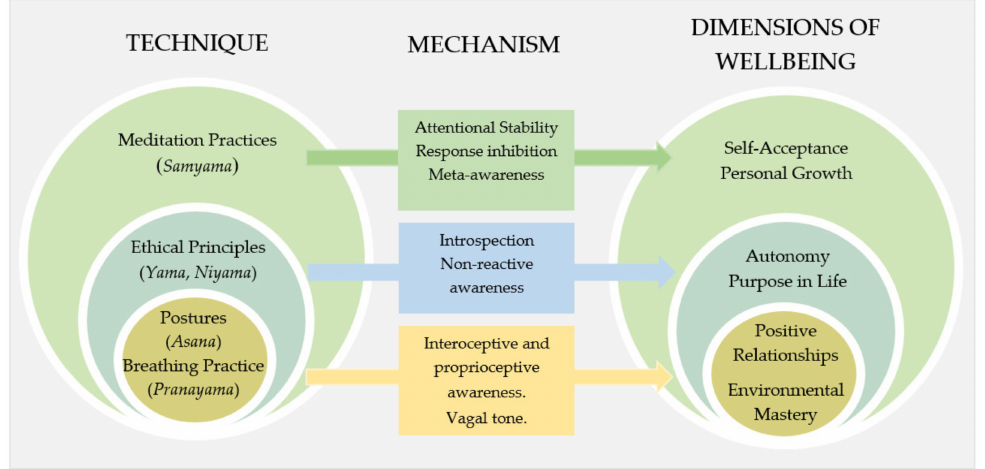
Figure 2. The interaction between the system of yoga and the dimensions of